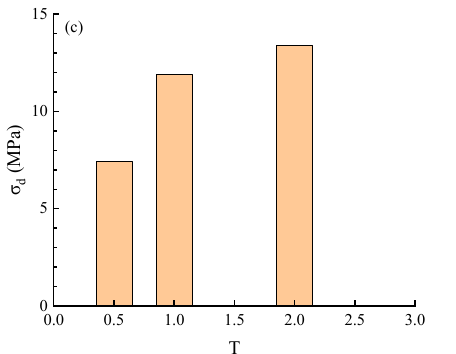
Figure 16. Dynamic strength dependence on PSD (Talbot Index) and component mixture type: ( a ) S 3 series; ( b ) S 4 series; ( c ) S 5 series.